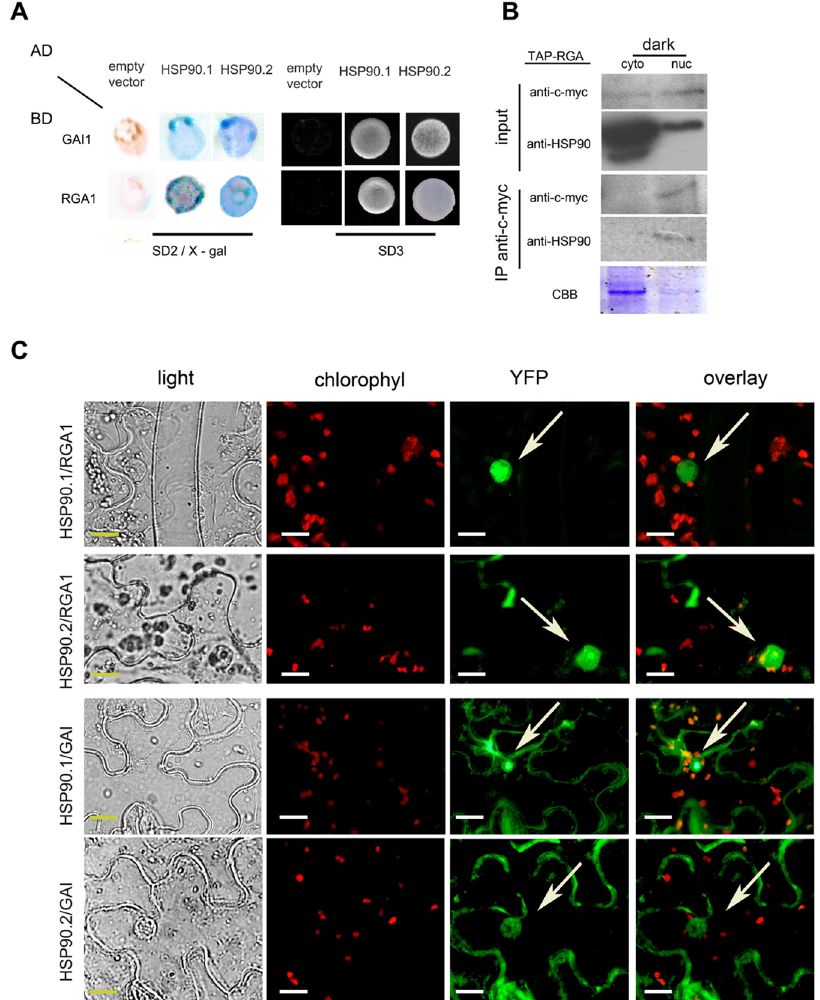
Figure 2. DELLA proteins, the negative regulators of GA pathway, are clients of the HSP90 molecular chaperone. ( A ) Yeast two-hybrid assays showing protein interactions between HSP90.1 or HSP90.2 and GAI or RGA, respectively. HSP90.1 or HSP90.2 were used as prey (AD), whereas GAI or RGA as bait (BD). Growth of co-transformants on SD -Leu-Trp medium (SD2) confirmed the presence of both bait (BD) and prey (AD) plasmids were present in yeast cells. The positive interactions between HSP90.1 or HSP90.2 and RGA or GAI were also verified on SD2/X-gal and on SD- Leu-Trp-His medium (SD3). ( B ) Co-immunoprecipitation assays showing interaction between HSP90 and RGA. in 6-day-old dark grown Arabidopsis seedlings. Coomassie brilliant blue (CBB) was used to evaluate protein levels in the cytoplasmic and nuclear fractions. ( C ) BiFC assays of HSP90.1- or HSP90.2-YFPc with GAI-nYFP or with RGA-nYFP in N. benthamiana leaf epidermal cells. Reconstituted fluorescent signal in nucleus and cytoplasm demonstrated protein–protein interactions. Arrows indicate the nuclei. Scale bars, 20 μ m.